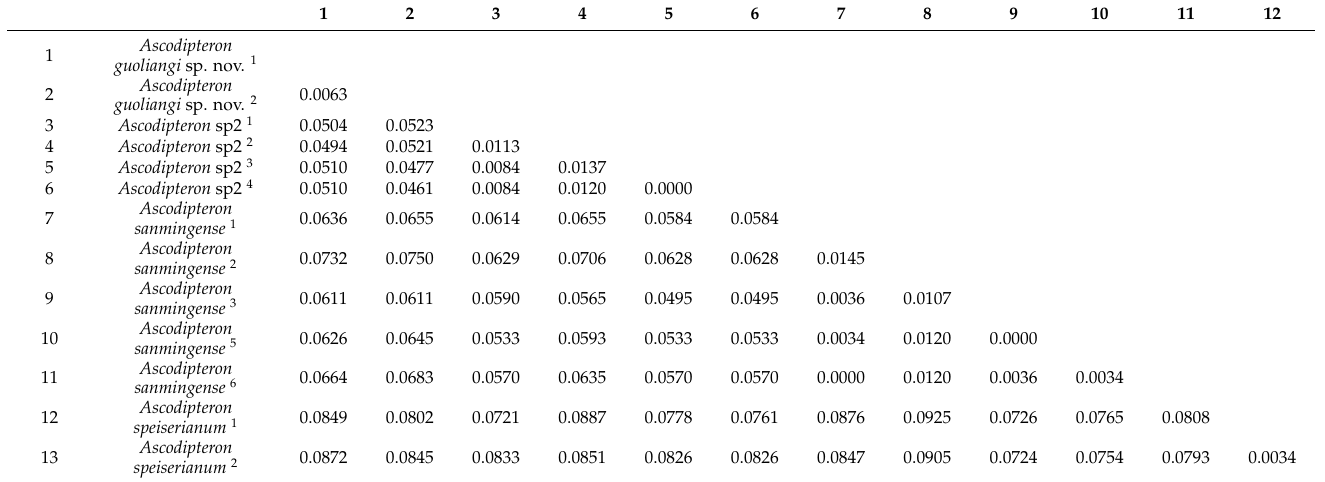
Table 3. Pairwise differences of cytochrome oxidase subunit I gene ( COI ) sequences between species, based on Kimura 2-parameter. Numbers in column headers refer to species and populations listed in their respective rows. Superscript numbers behind binomial names indicate different specimens of the same species, from different hosts and/or habitats. All specimens are neosomes obtained from host except number 9, which emerged from